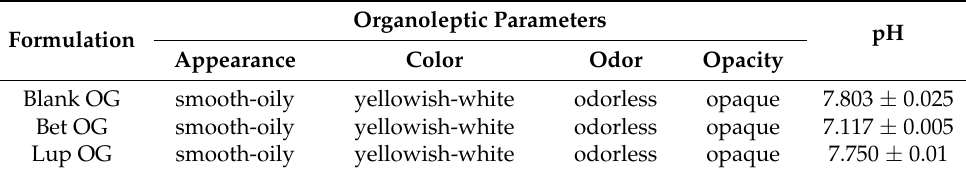
Table 1. Organoleptic parameters and pH values of the as-synthesized experimental oleogels.